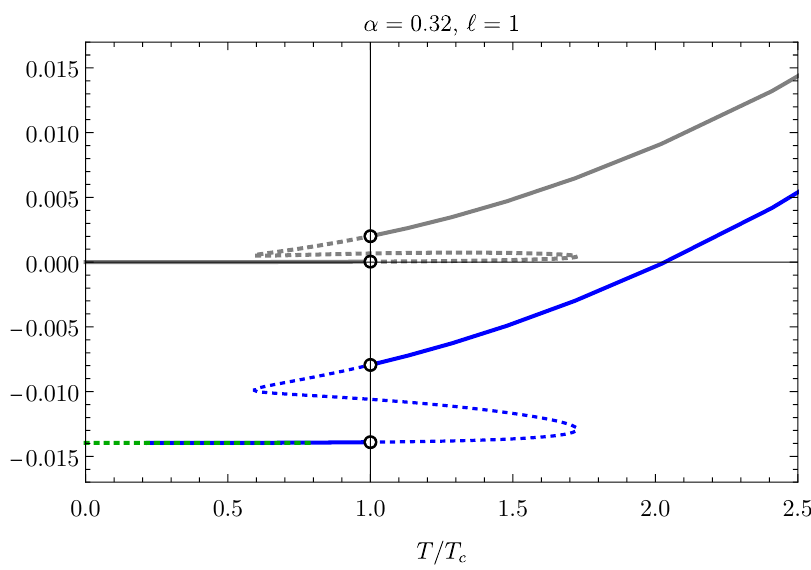
Figure 15 . QNEC 2 as function of T for black brane solution with α = 0 . 32 and ‘ = 1 . Blue lines (cid:0) (cid:1) show the QNEC 2 expression 1 S 00 + 6 ( S 0 ) 2 and gray lines show h T kk i , where solid (dashed) parts 2 π c of the curves correspond to thermodynamically stable (unstable) phases. In addition, the dashed green curve shows the value of QNEC 2 of the corresponding T = 0 domain wall solution.